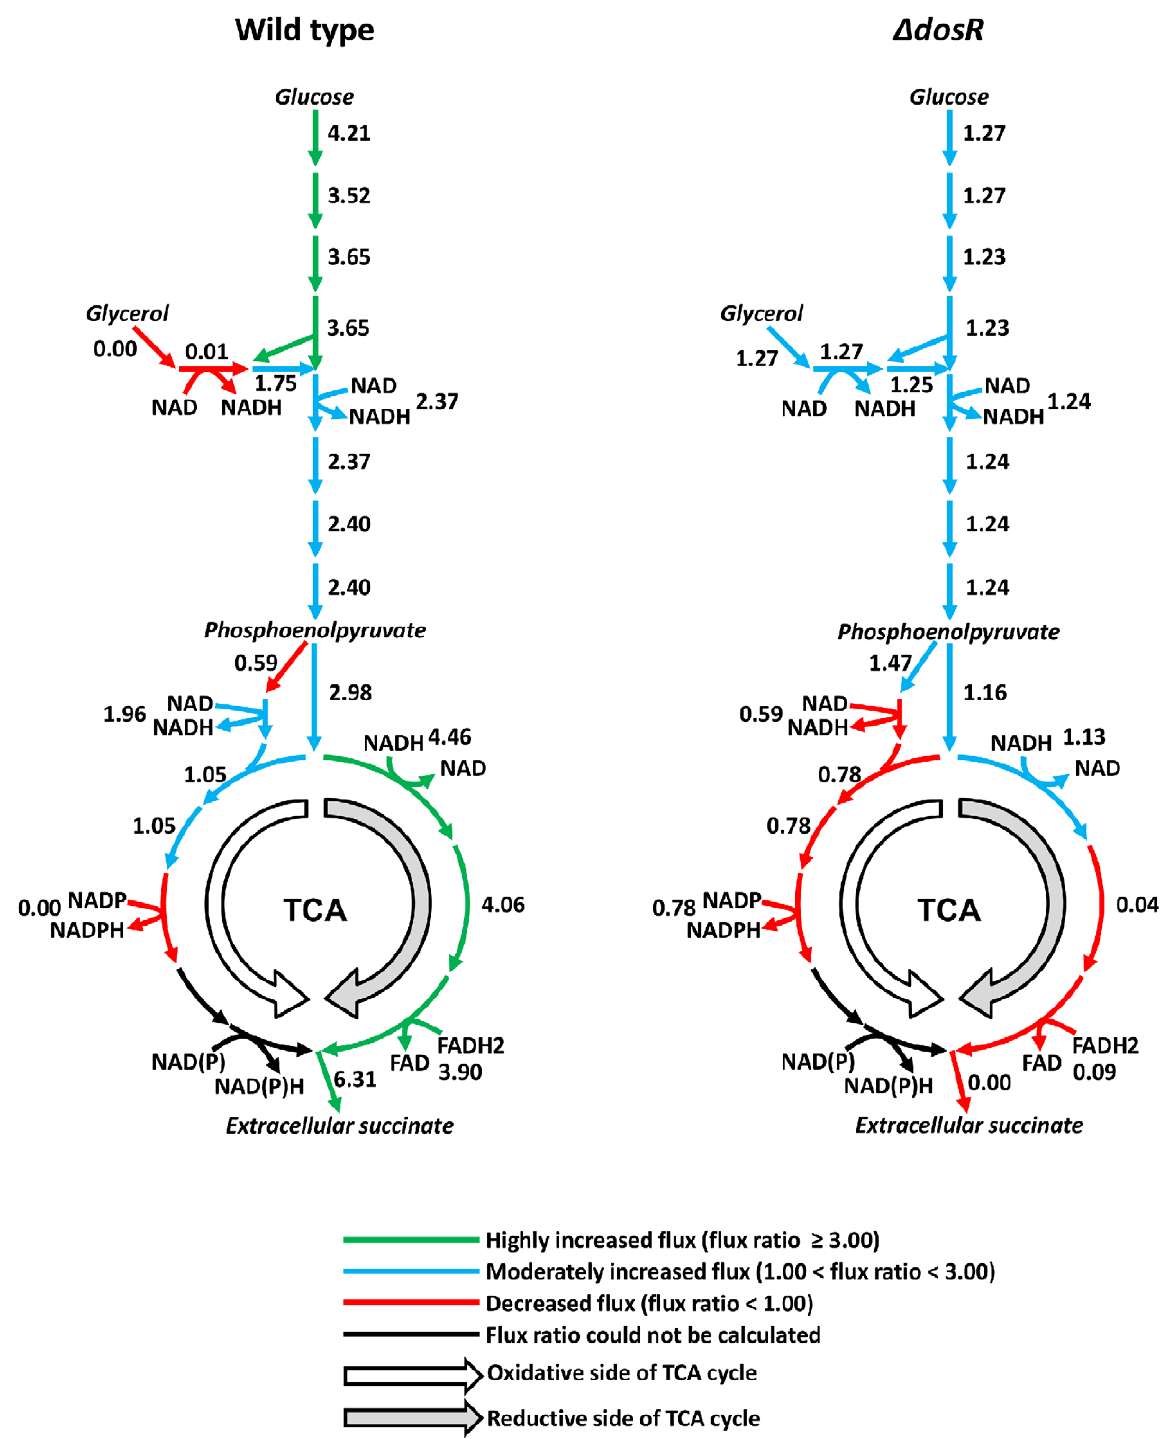
Figure 5. Predictions of hypoxia-induced changes in fluxes through central carbon metabolism. The left panel shows the flux ratios, i.e., the ratios of reaction fluxes under hypoxia to those under normoxia, of wild type Mycobacterium tuberculosis H37Rv and the right panel shows those of the D dosR deletion mutant. If the normoxic flux of a reaction was close to zero, we did not calculate the flux ratio for this reaction due to the numerical uncertainty associated with creating the corresponding ratio. The results indicated that the wild type strain activated glucose processing pathways and the predominant reaction flow was on the reductive side of the tricarboxylic acid (TCA) cycle. Conversely, the D dosR deletion mutant was not able to cope under hypoxic conditions as evident by an overall reduced activity in the TCA cycle. NAD, nicotinamide adenine dinucleotide; NADP, nicotinamide adenine dinucleotide phosphate; FAD, flavin adenine dinucleotide. NADH, NADPH, and FADH2 are the reduced forms of NAD, NADP, and FAD, respectively. NAD(P), NAD or NADP; NAD(P)H, NADH or NADPH.